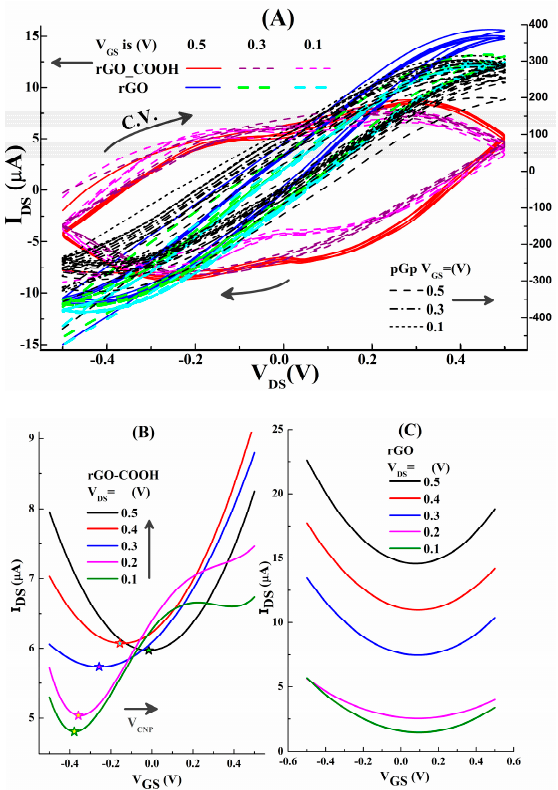
Figure 4. ( A ) Output features of rGO-COOH, rGO and pGp channeled GFETs. ( B ) and ( C ) The transfer curves of rGO-COOH and rGO, respectively. curves of rGO-COOH and rGO,